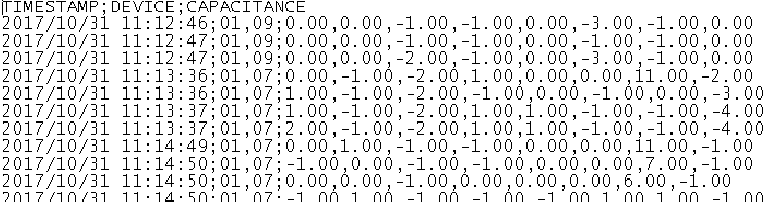
Figure 13. Layout of the smart floor in the UJAmI